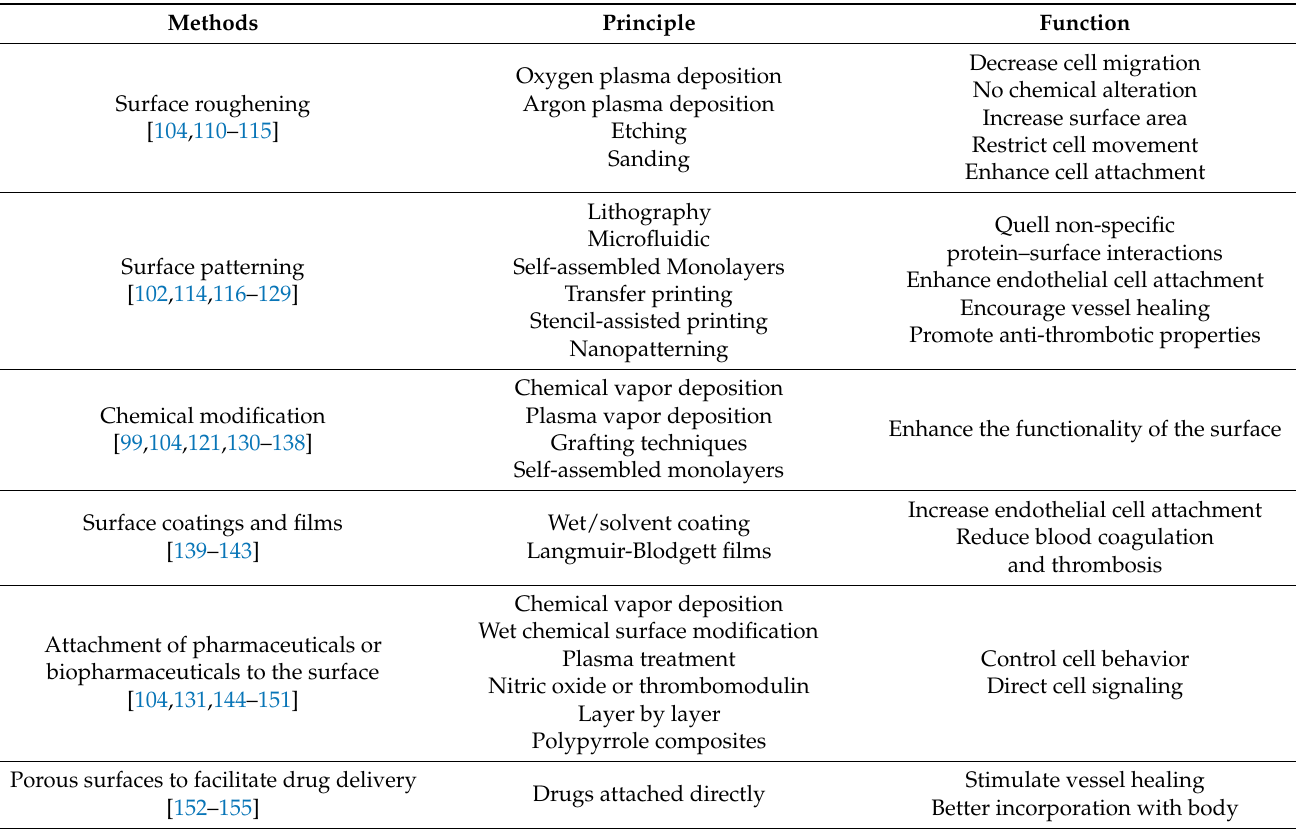
Table 2. Surface modification